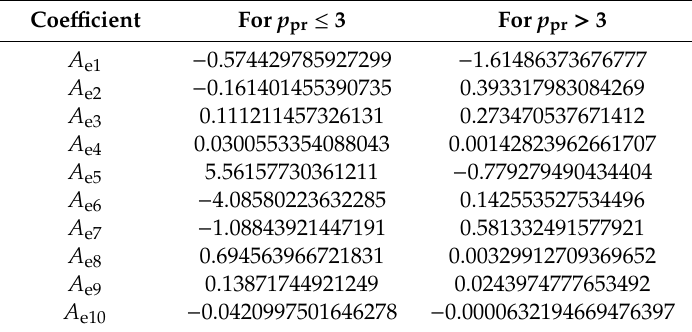
Table 7. Values of coe ffi cients in Equation